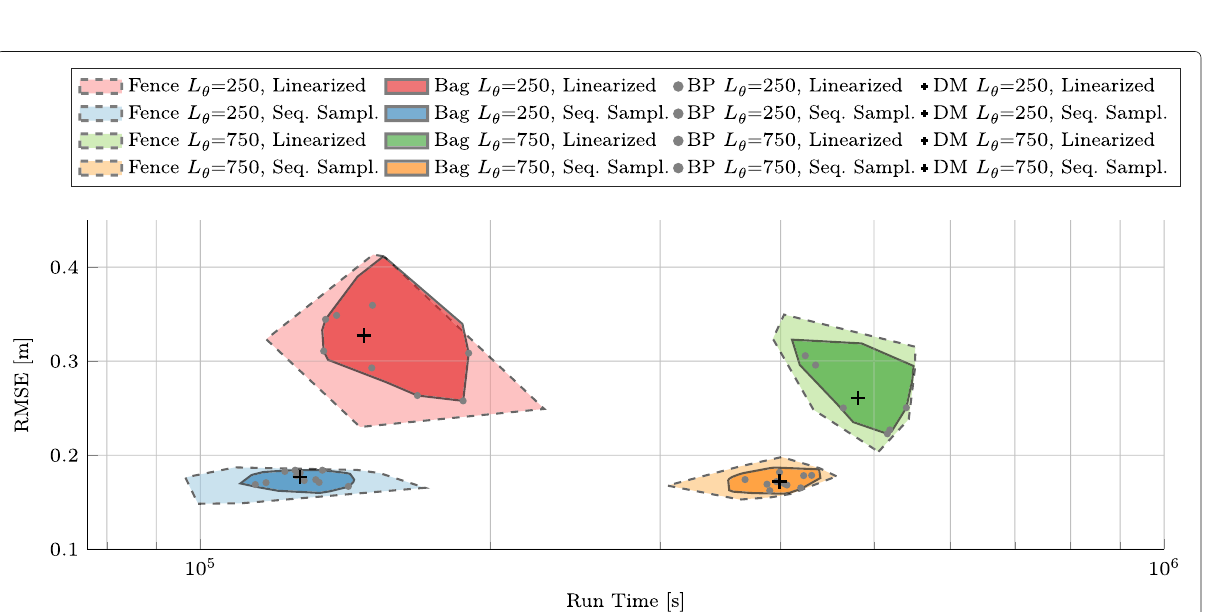
considering larger L θ values. The corresponding results are presented in Fig. 11, which compares the best- performing IPF configuration with a series of RFaT configurations. Both panels show that RFaT offers sig- nificantly improved localization accuracy at the cost of a higher computational complexity. For example, for MNS 2 (right panel), the RMSE can be reduced by 33% and 50% by employing L θ = 10 and L θ = 100 parameter particles, respectively. However, this would require an additional 1100 s and 8100 s, respectively, of computing time.